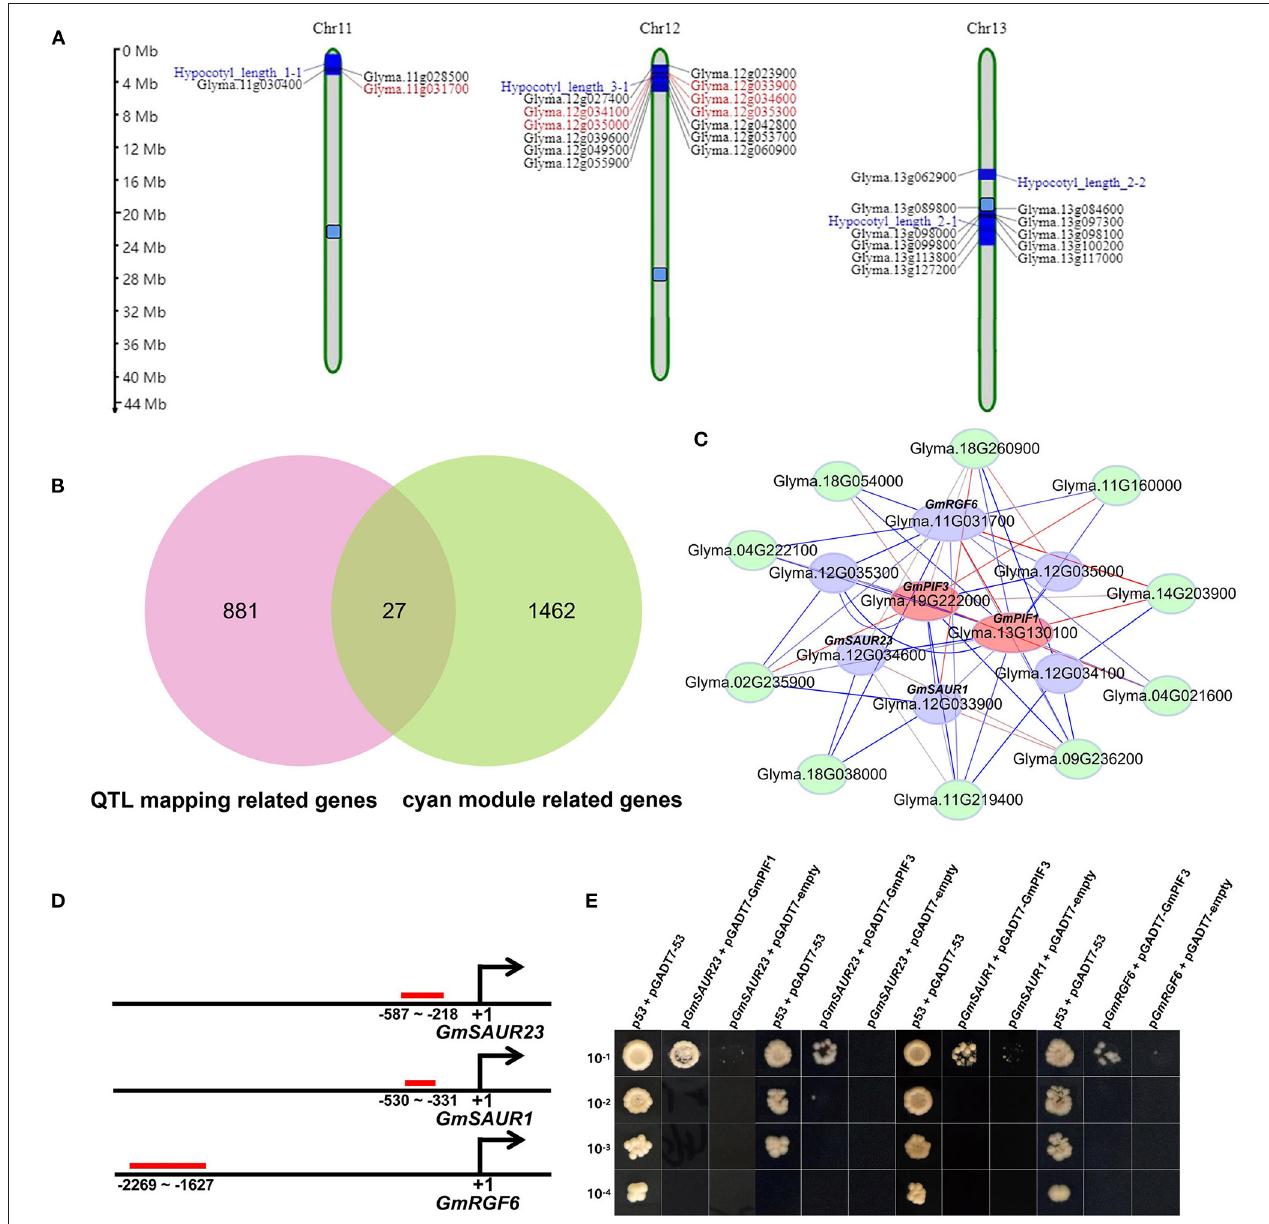
FIGURE 3 | Construction of a GmPIFs - GmSUAR s/ GmRGF6 submodule regulating hypocotyl elongation. (A) Distribution of 27 common members between the cyan module and hypocotyl elongation related QTLs on chromosomes. The blue block indicates location of QTLs. The light bule block indicates position of centromeres. Genes in red are GmSAUR s and GmRGF6 . (B) Venn diagram showing the intersection of the cyan module with hypocotyl elongation related QTLs. (C) Gene co-expression network in GmPIFs - GmSUAR s/ GmRGF6 submodule. Color of the lines indicates weight value: red indicates high value and blue indicates low value. (D) GmPIFs bind to the promoter regions of GmSUARs and (E) GmRGF revelaed by Y1H assays. Red lines indicated the potential binding regions of GmPIFs.